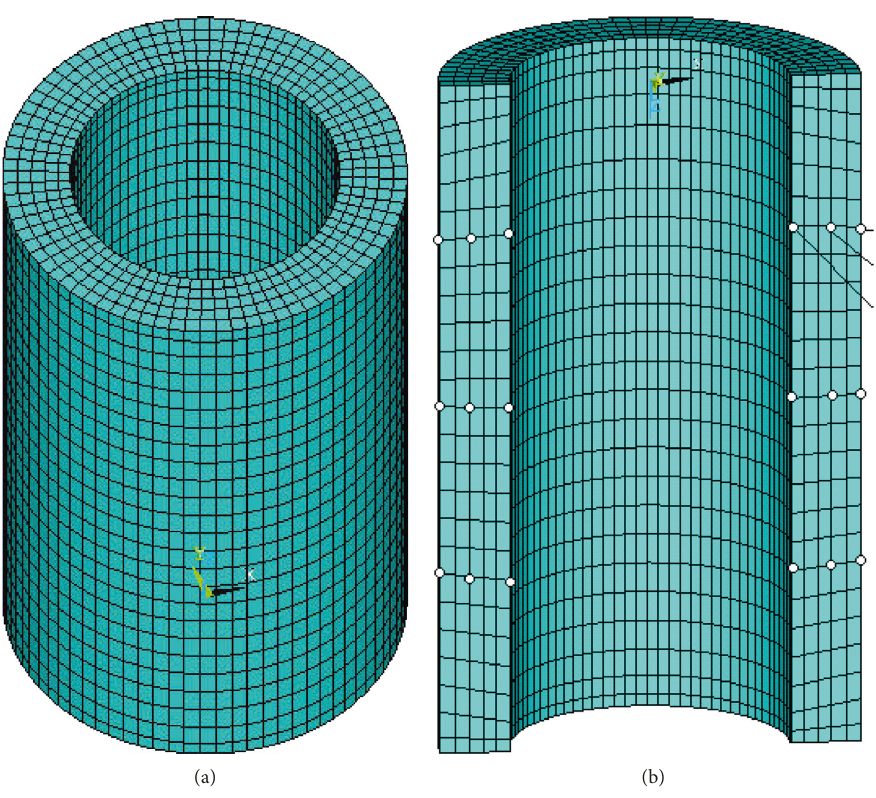
Figure 13: FEM model and element